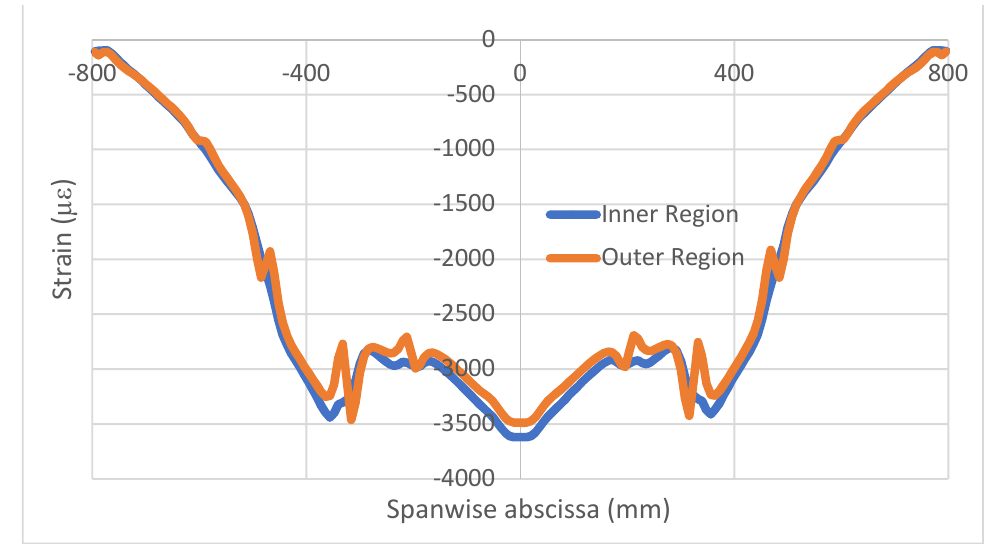
Figure 9. Strain profiles, inner (bottom) and outer (top) cap fiber; symmetrical load.